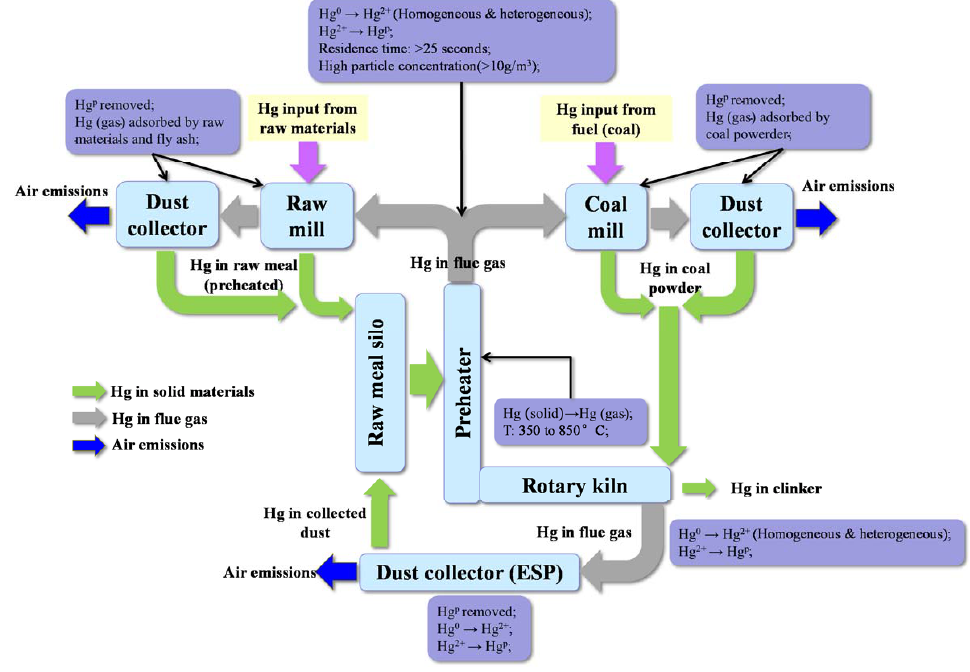
Figure 4. Mercury transformation in the precalciner cement production